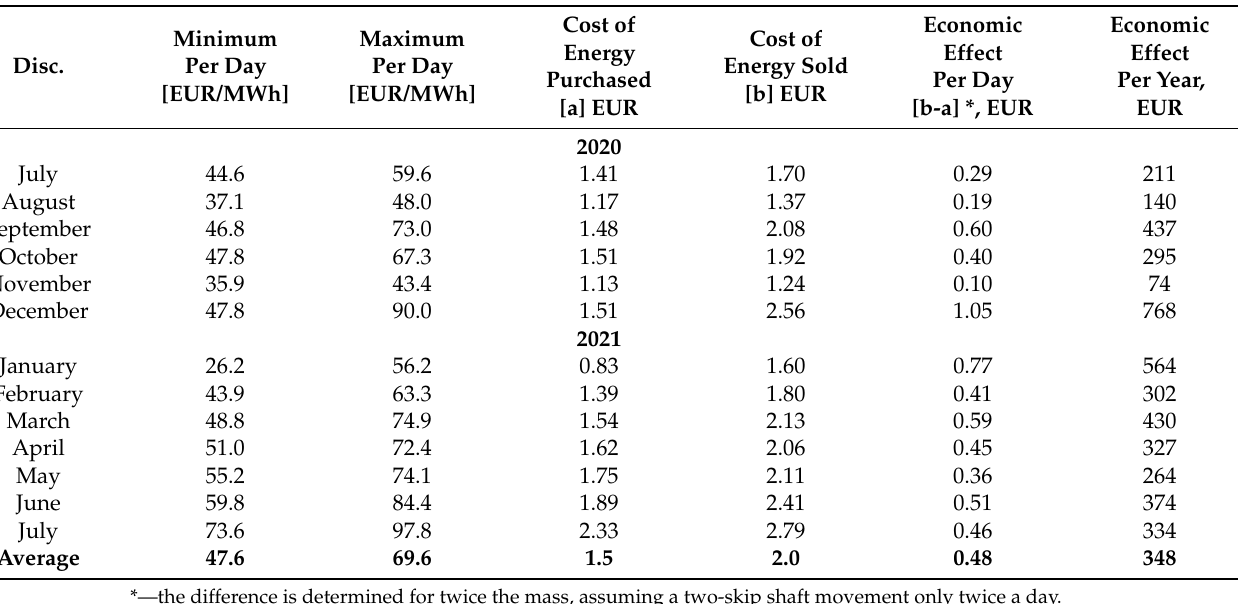
Table 4. Analysis of storing energy in the shaft.